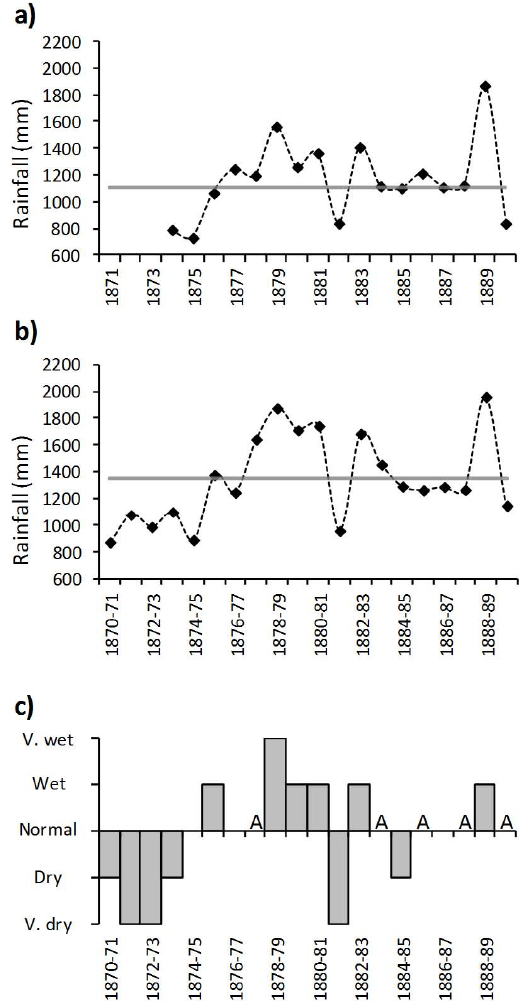
Fig. 4. (a) Instrumental rainfall data for Antigua, 1874 to 1890, av- eraged from multiple measurements by Auchinleck (1956). Black diamonds display annual totals for calendar years; grey line dis- plays annual mean for calendar years 1874–1949. (b) Instrumne- tal rainfall data for St. John’s, 1870–71 to 1889–90, from Oliver (1894), CO157/2, CO157/3 and CO157/4. Black diamonds indi- cate totals for each rain-year; grey line represents annual mean. (c) Documentary-derived chronology of average rainfall conditions throughout Antigua, rain-years 1870–71 to 1889–90. A denotes as- sumed “normal”